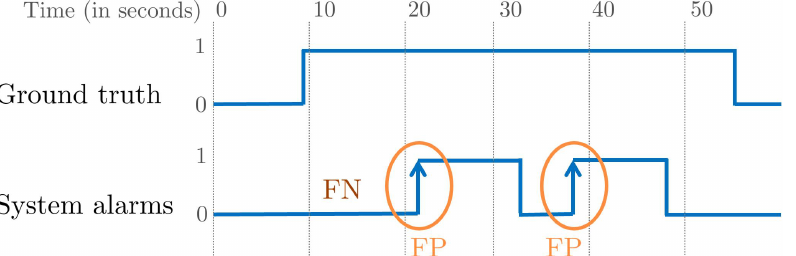
Figure 7. Illustration of i-LIDS evaluation protocol, highlighting its drawback on an intrusion example starting at 9th second. Since no alarm has been raised in the first 10 s of the intrusion, a FN is counted. Following alarms, at 22nd and 37th second, are marked as FP because they do not occur within 10 s from the beginning of the